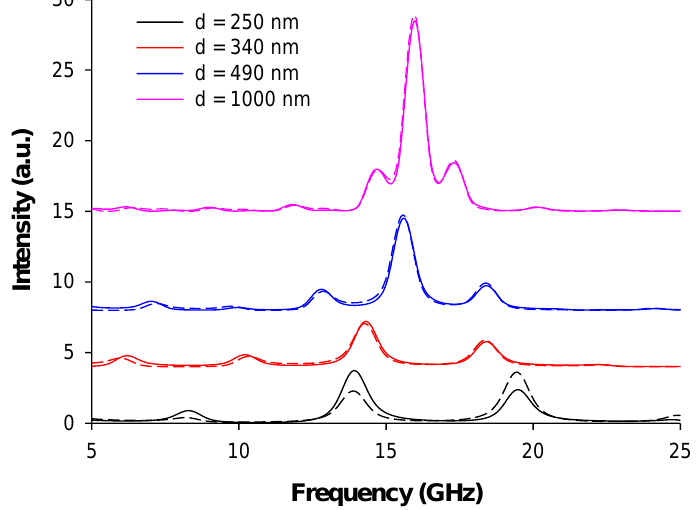
Figure A1. Theoretical Brillouin light scattering spectra displayed at q = 0.036 nm −1 for a series of supported PMMA films with different thicknesses deposited on Si substrate, with (continuous curves) and without (dashed curves) taking into account the deformation of the interfaces.